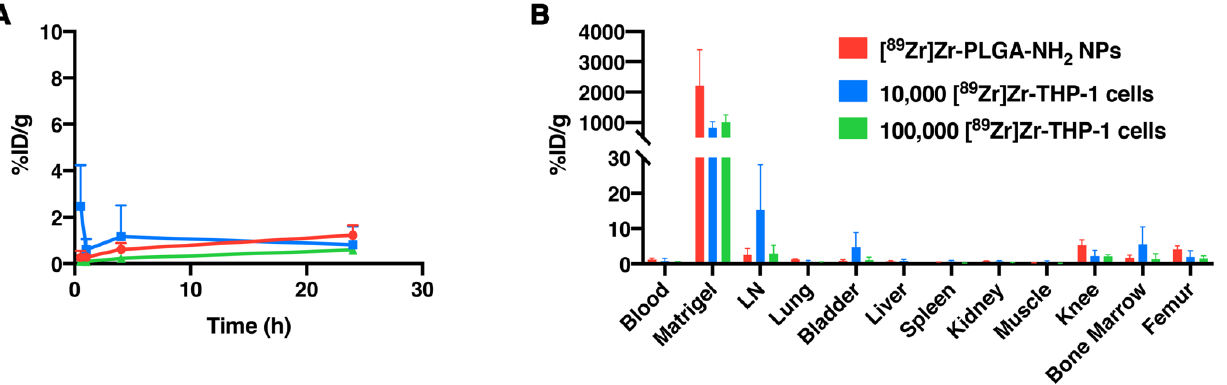
Figure 5. Blood values and biodistribution of [ 89 Zr]Zr-THP-1 cells in BALB/cAnNRj-Foxn1nu/Foxn1nu mice. ( A ) Blood values of [ 89 Zr]Zr-PLGA-NH 2 NPs ( n = 4), 10,000 [ 89 Zr]Zr-THP-1 cells ( n = 4) and 100,000 [ 89 Zr]Zr-THP-1 cells ( n = 4) after subcutaneous injection in BALB/cAnNRj-Foxn1nu/Foxn1nu mice, measured at 0.5, 1, 4 and 24 h post-injection. ( B ) Matrigel and organ accumulation of the [89Zr]Zr-PLGA-NH2 NPs, 10,000 [89Zr]Zr-THP-1 cells and 100,000 [89Zr]Zr-THP-1 cells in the same mice. Abbreviations: %ID/g, % injected dose per gram of organ; LN, lymph node.